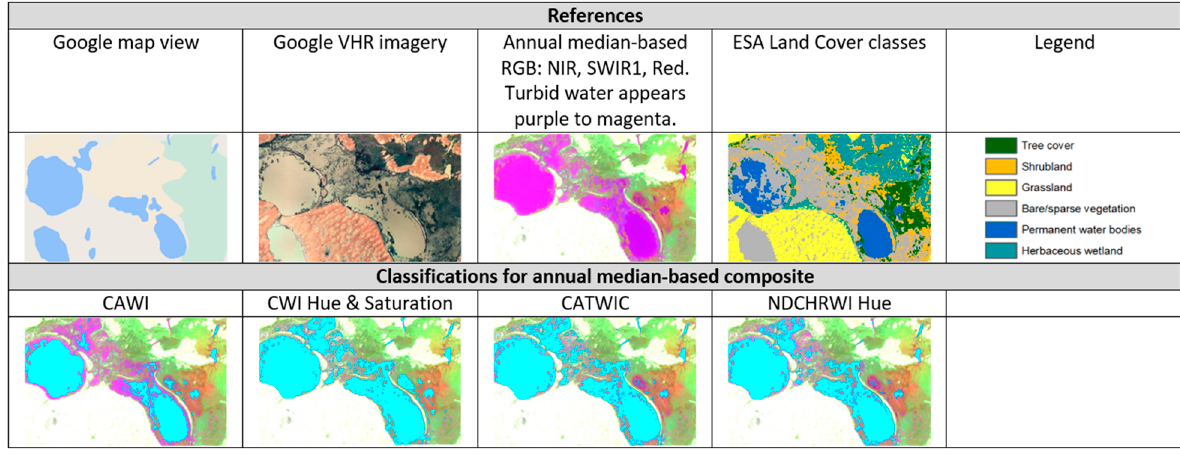
Figure 6. Index performance comparison in a coastal wetland area. Location: Twelve Mile Creek, NSW, Australia (151.92467, − 32.7285). Reference RGB: NIR, SWIR1, Red, min: 0, max: 0.3. Yellow circles indicate misclassifications. Estuarine macrophytes from Seamap Australia (Bulter et al. 2017).